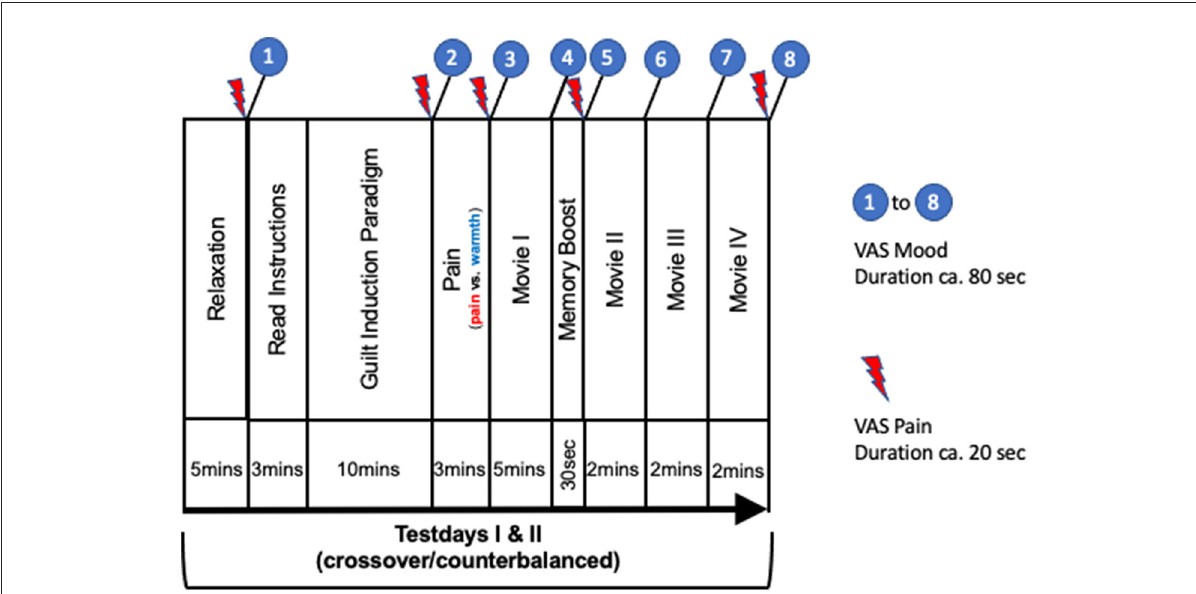
FIGURE1 Summary of procedures. Numbers 1–8 refer to mood-state (duration ca. 80s) and red arrows to pain recordings (duration ca. 20s) collected using digital VAS: (1) Baseline assessments before guilt induction; (2) After reading instructions and writing of guilt-inducing essay; (3) After pain stimulation; (4) After movie I; (5) After memory boost; (6–8) After movie ll, lll, lV, respectively. In total 8 mood (e.g. I feel guilty: 0 = not at all; 10 = entirely) and 5 pain VAS ratings (0 = no pain at all − 10 = maximum pain/unpleasant imaginable) were recorded throughout the